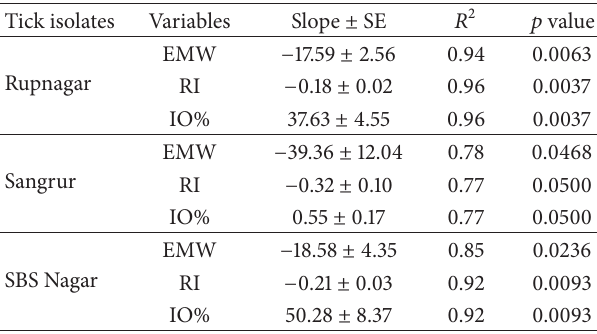
Table 1: Slope, 𝑅 2 , and 𝑝 values of reproductive parameters of different isolates of R. ( B. ) microplus upon AIT with malathion.